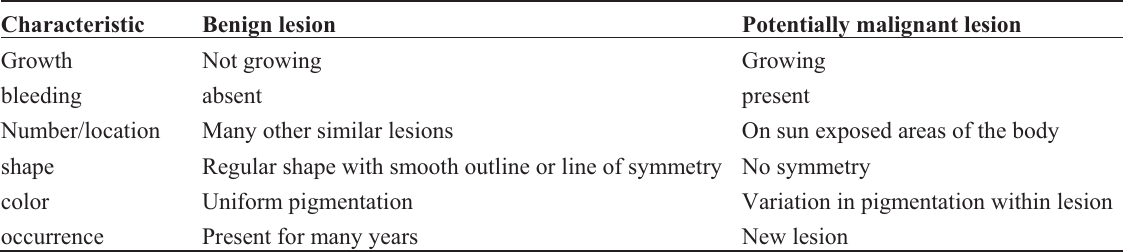
Table 2. Characteristics of benign vs . malignant